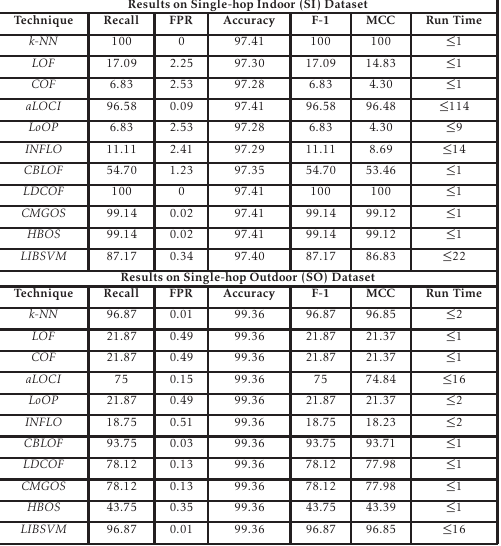
Table 7. Performance of Anomaly Detection Techniques on Datasets with Injected Anomalies (Single-Hop) ResultsonSingle-hopIndoor(SI)Dataset Technique